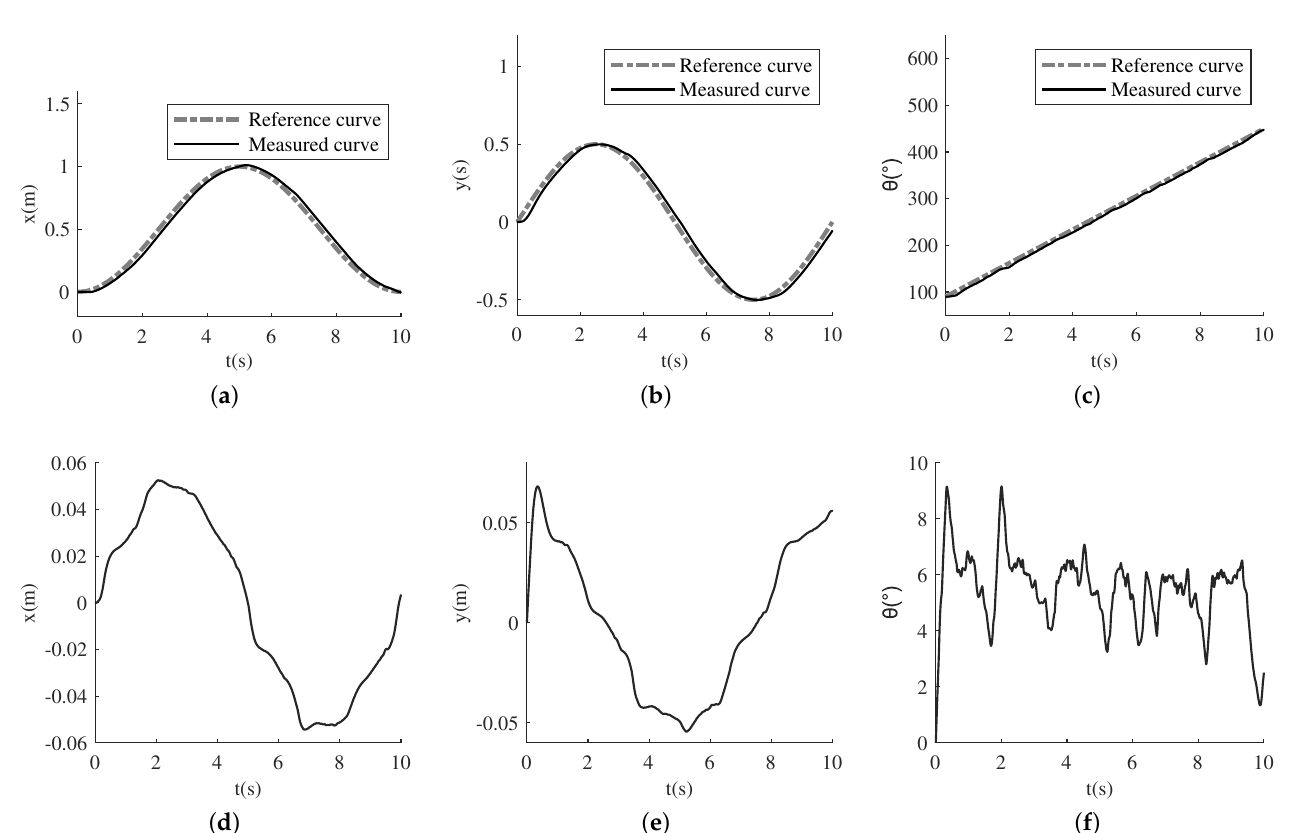
Figure 12. The result of PID controller in the simulation experiment. ( a ) X-directional position–time curve in PID experiment. ( b ) Y-directional position–time curve in PID experiment. ( c ) Orientation–time curve in PID experiment. ( d ) Error of X- directional position–time curve in PID experiment. ( e ) Error of Y-directional position–time curve in PID experiment. ( f ) Error of Orientation–time curve in PID